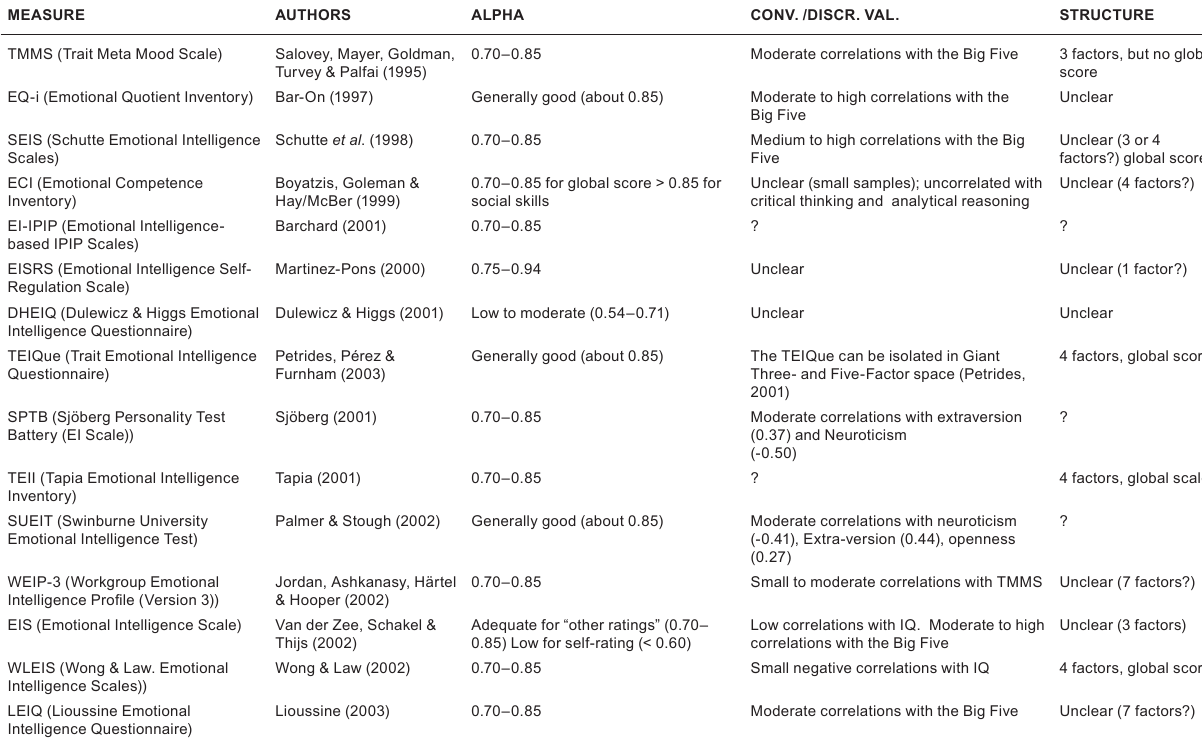
table 2 Summary of trait EI